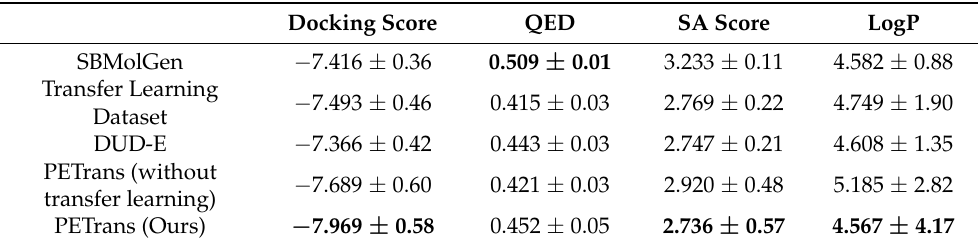
Table 1. The comparison of the properties of the molecules in the transfer learning dataset and the molecules generated by different methods.